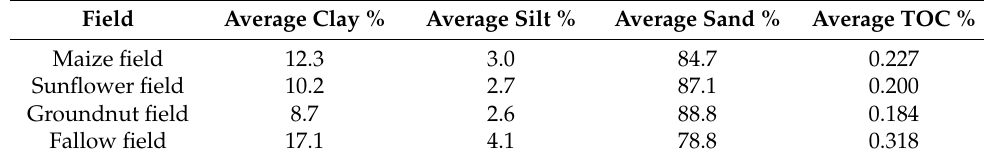
Table 2. The average soil texture and Total Organic Carbon (TOC) content of the four fields. Field